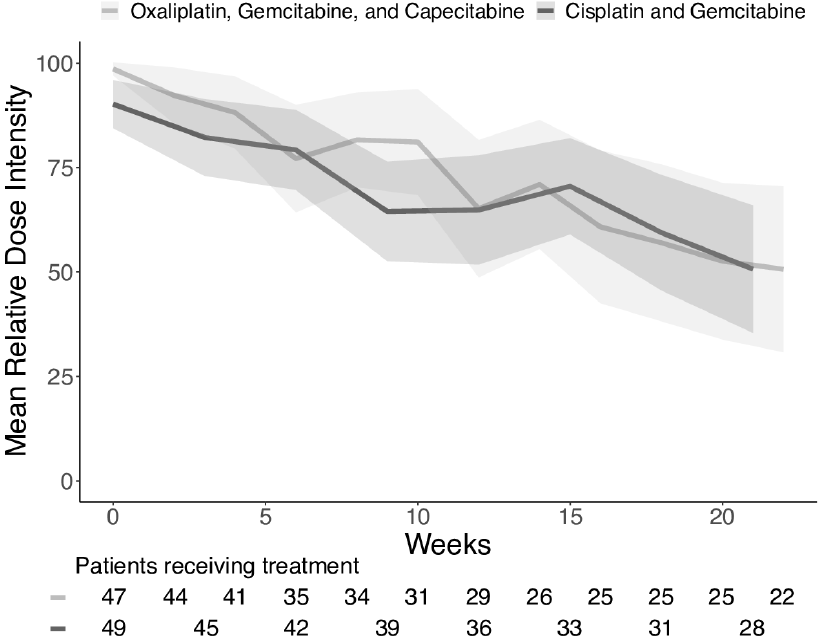
Figure 3. Mean relative dose intensity of the two treatments with 95% confidence intervals. It can